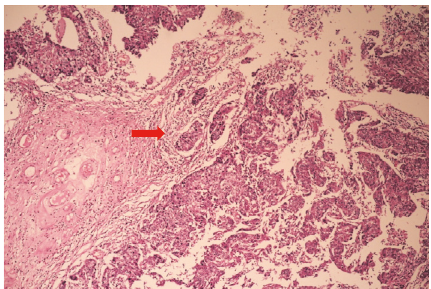
Figure 4: Low power view of urothelial carcinoma with arrow pointing at nests of invasive malignant epithelial cells in ovarian stroma (H&E 10X magnification).